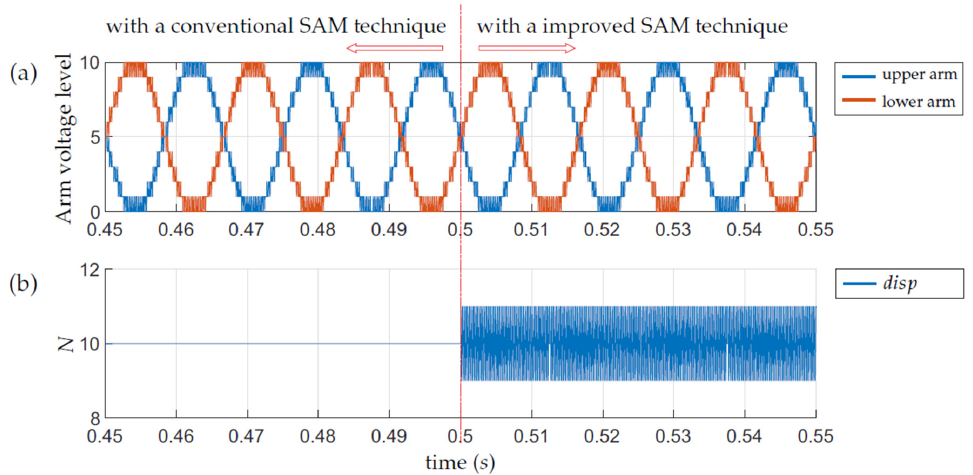
Figure 13. Dynamic performance of MMC, whit SAM and improved SAM techniques. ( a ) the upper and lower arm voltage levels; ( b ) the total inserted submodule